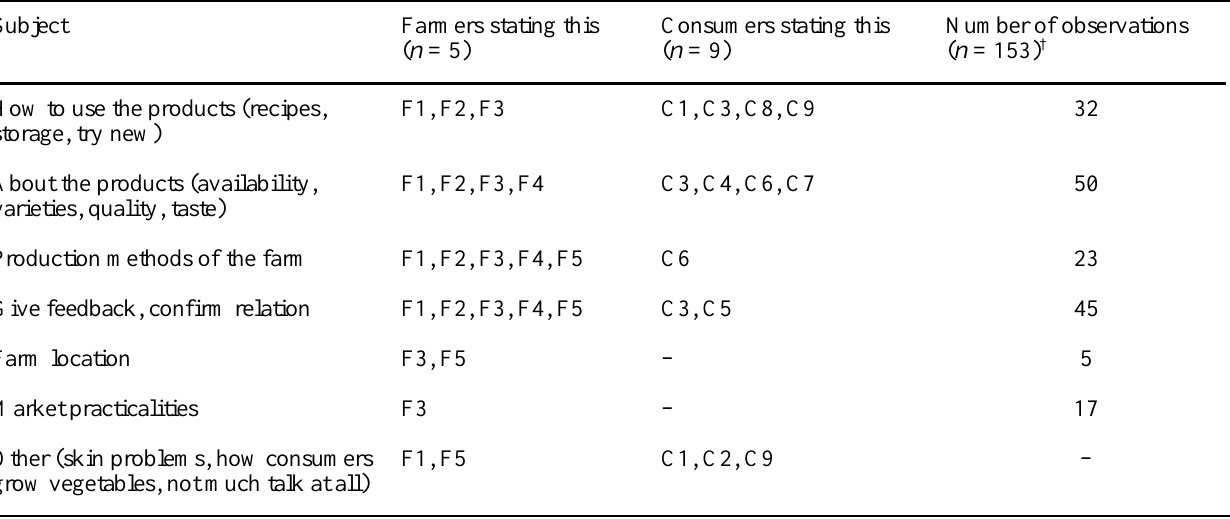
Table 3 . Things farmers and customers talked about at the farmers'